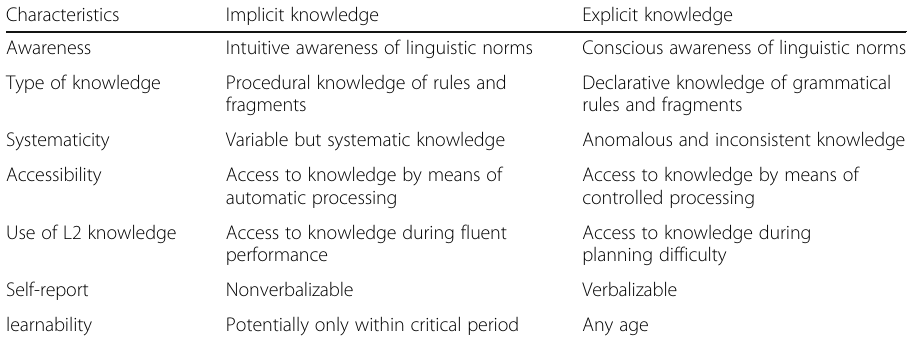
Table 1 Key characteristics of implicit and explicit knowledge (Adapted from Ellis, 2005)